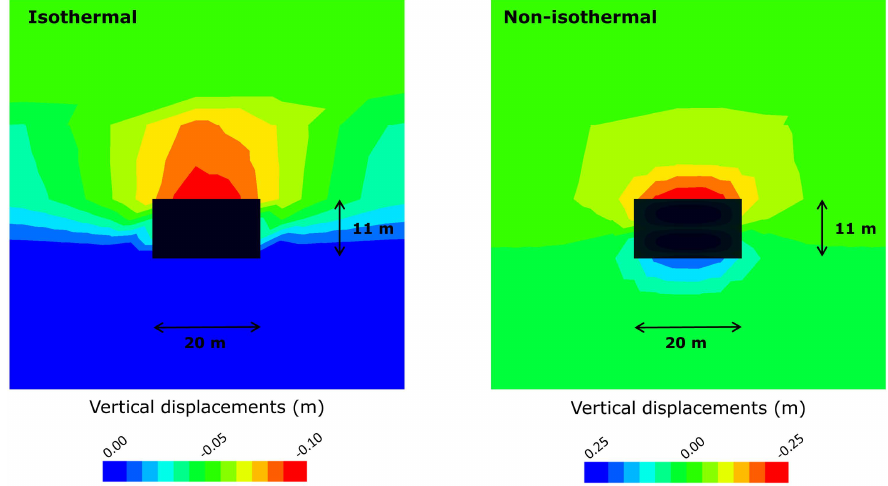
Figure 6. Vertical displacements in close vicinity of one UCG channel located at the A–B profile shown in Figure 5 for the: isothermal ( left ) and non-isothermal ( right )